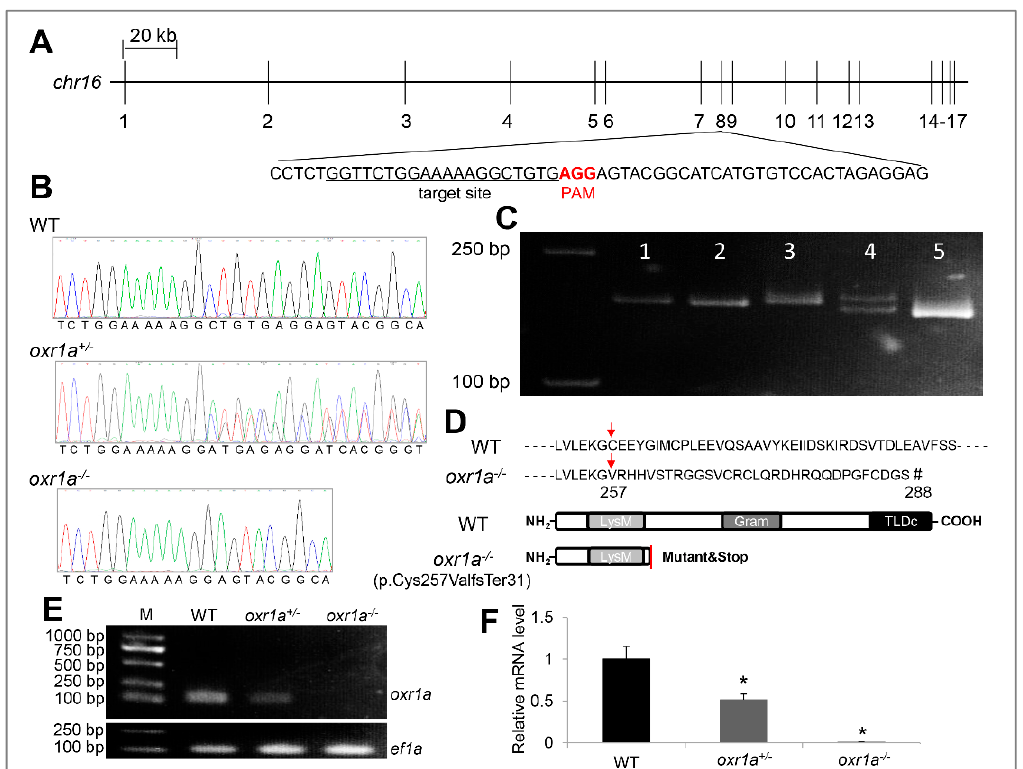
(Figure 3D). Further RT-PCR and qPCR using a deletion-specific primers ( oxr1a -F2 / R2) also determined that transcription of oxr1a is completely interrupted in homozygous mutants (Figure 3E,F).